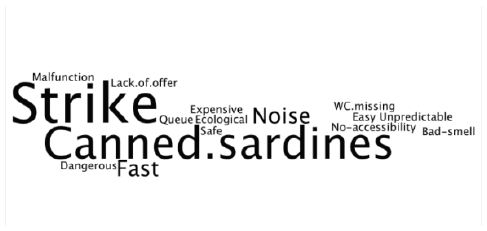
Figure 3. Word cloud of subway transport inside Lisbon municipality.